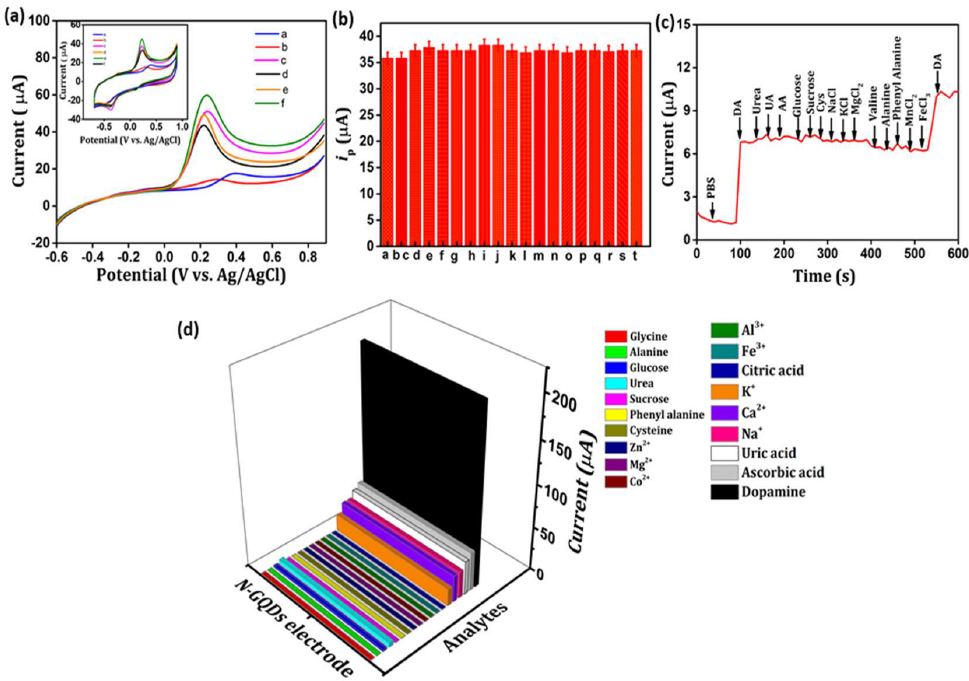
Figure 5. ( a ) LSV of 1 mM AA (trace a), 1 mM UA (trace b), 0.01 mM DA (trace c), DA in the presence of AA (100 fold, trace d), UA (100 fold, trace e), and mixtures of other interfering bioactive molecules and ions (trace f). The inset of ( a ) is the corresponding CV responses. ( b ) The measured I pa at a scan rate of 100 mv/s in 0.01 mM DA with the different interferences. ( c ) Selectivity testing using amperometric detection of 0.05 mM dopamine with interfering molecules. ( d ) A plot of different analytes vs. current I pa (CV response).